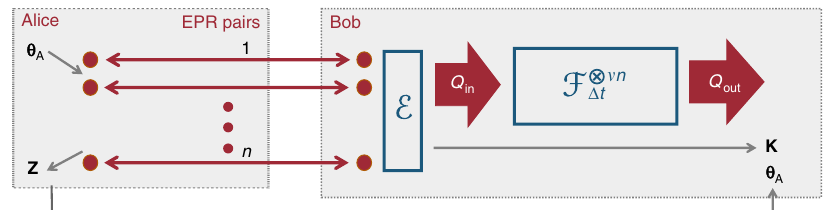
Fig. 1 The general form of an attack of dishonest Bob. Alice measured her mode of distributed EPR pairs with homodyne quadratures θ A , yielding (discretized) results denoted Z . Bob ’ s memory attack is modeled by an encoding E that maps (conditioned on some classical outcome K ) the n modes to the memory input Q in . The memory M is modeled by ν n uses of the channel F Δ t . We consider the situations where the encoding E is arbitrary, a mixture of Gaussian channels or independent and identical over a small numbers of signals m